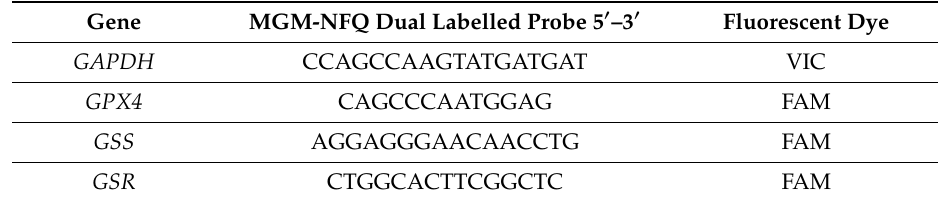
Table 3. Dual labelled probes for target and endogenous control genes. Minor groove binder-non- fluorescent quencher (MGB-NFQ) quencher was used in all